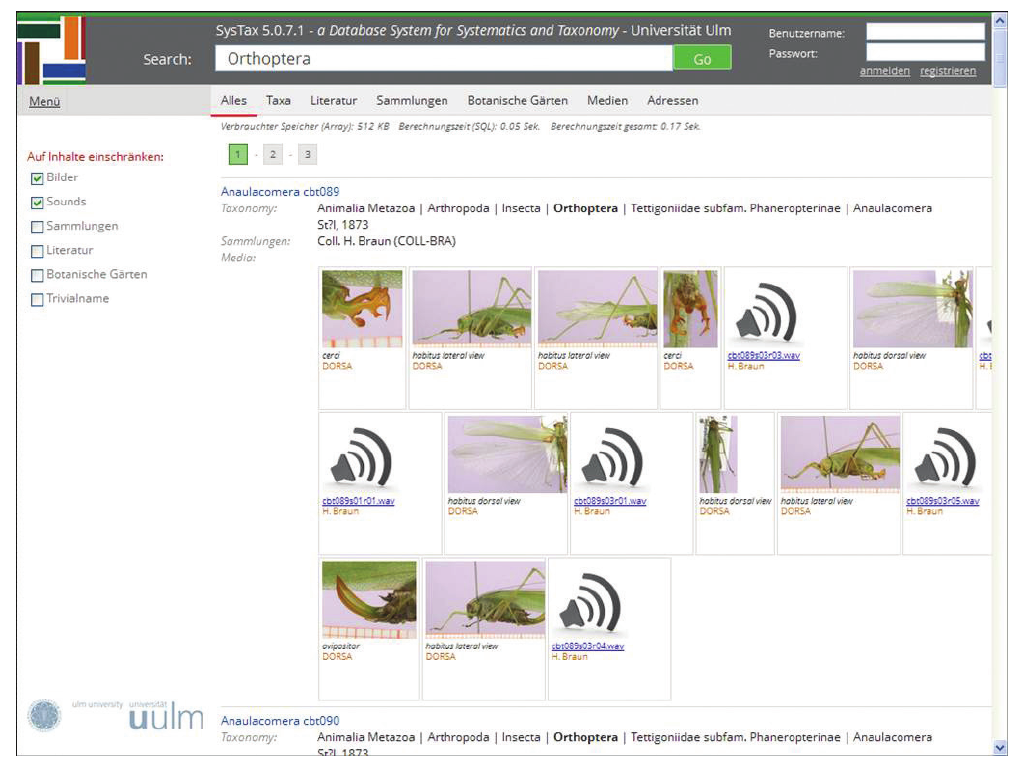
Fig. 2. The SYSTAX database. Screenshot of the new SYSTAX user interface, to be released under www.systax.org. A search for the Neo- tropical tettigoniid genus Anaulacomera recovers several sound recordings from a voucher specimen of a hitherto undescribed species, documented by photographs. Faceting allows searching by images or sounds